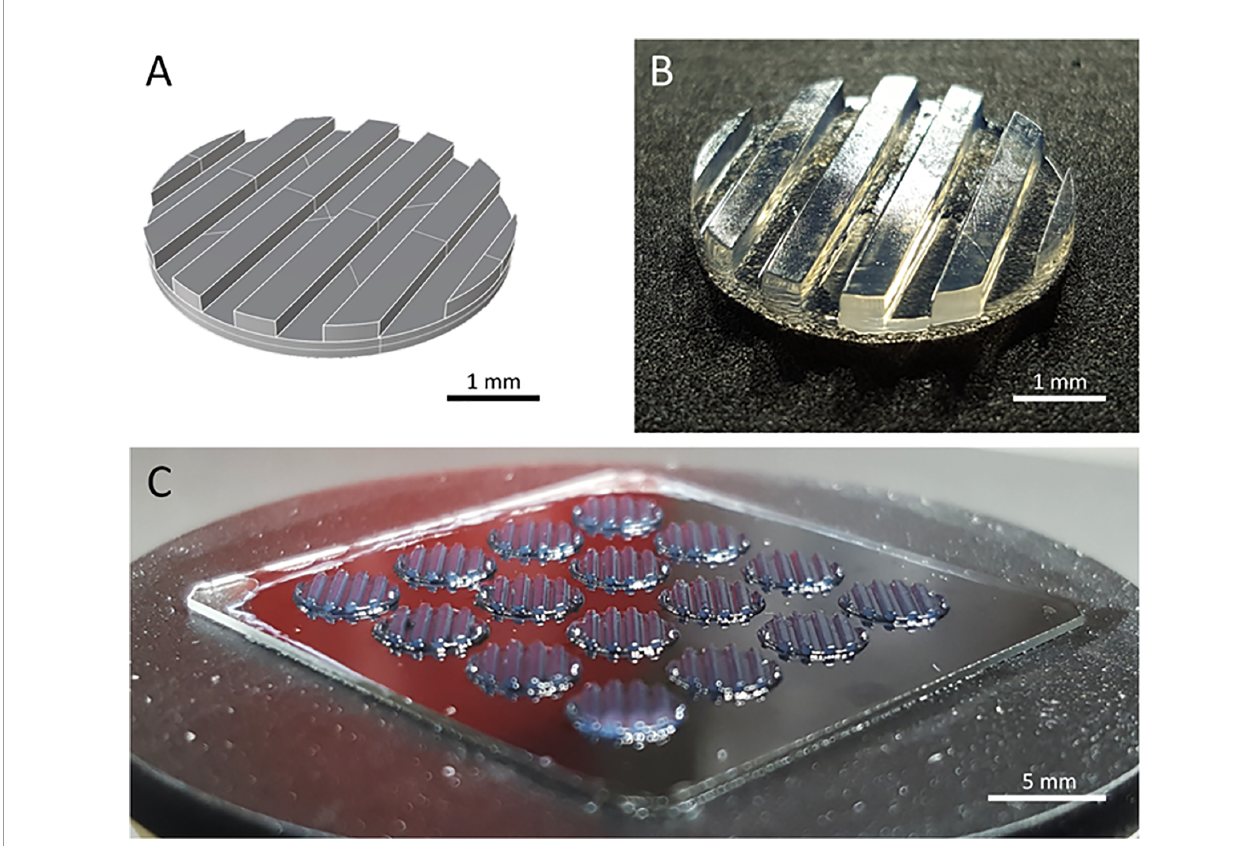
FIGURE 1 | The bioprinted 3D neuroblastoma tumor model. (A) Computer-assisted design fi le (CAD) used for printing the 4 mm diameter and 500 μm depth model. (B) Macroscopic photograph of bioprinted 3D tumor model. Scale bar = 1 mm. (C) An array of 16 multiple tumor models directly after printing. Scale bar = 5